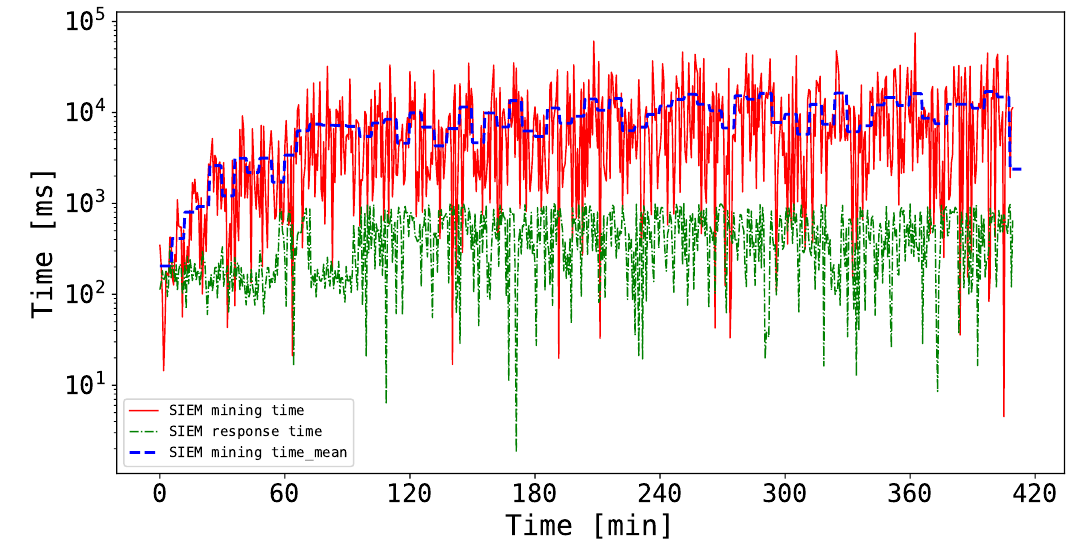
Figure 7. SIEM mining and response times in logarithmic